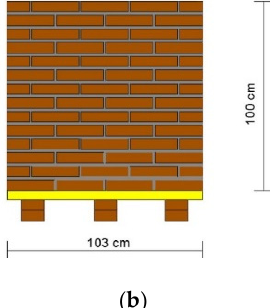
Figure 1. ( a ) Masonry panel texture, ( b ) panel geometry.